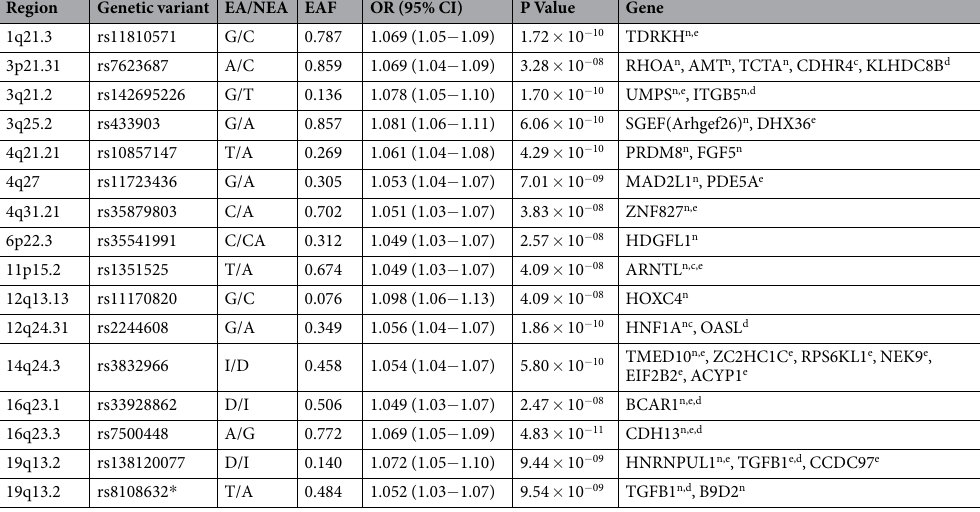
Table 1. Fifteen novel genome wide associated loci for coronary artery disease. Data presented here is from the meta-analysis; full summary statistics are available in supplementary Table 3. Abbreviations: EA = effect allele, NEA = Non-effect allele, , EAF = effect allele frequency , OR = Odds Ratio , CI = confidence interval , I = Indel, D = Deletion. Candidate gene superscripts indicate the method of identification (n = nearest gene, c = coding gene, d = depict gene, e = eQTL gene). * Denotes the secondary signal in locus of region